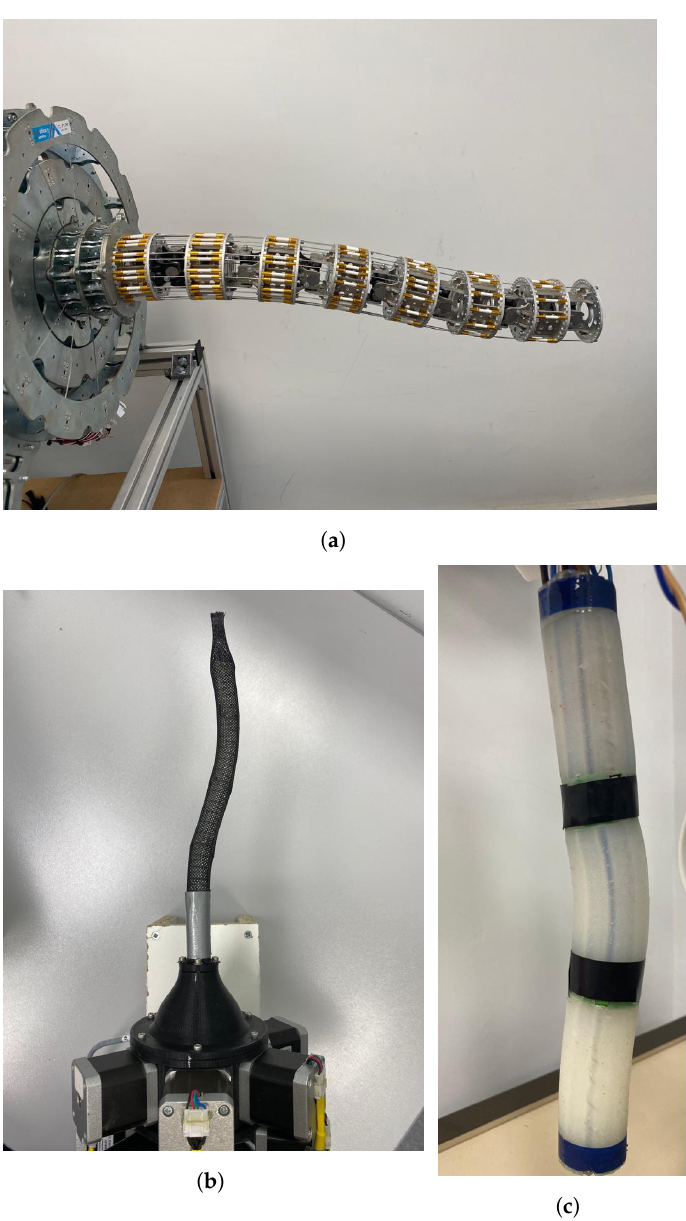
Figure 1. Three examples of CDHR exemplifying each category. ( a ) MACH-I: a discrete CDHR. ( b ) Pilory: a constant curvature CDHR. ( c ) Ruan: a soft